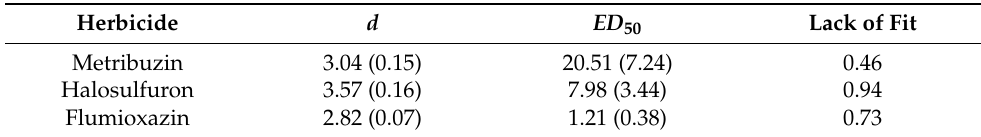
Table 1. Estimated sigmoidal parameters for metribuzin, halosulfuron and flumioxazin on C. album . Standard errors in parentheses.